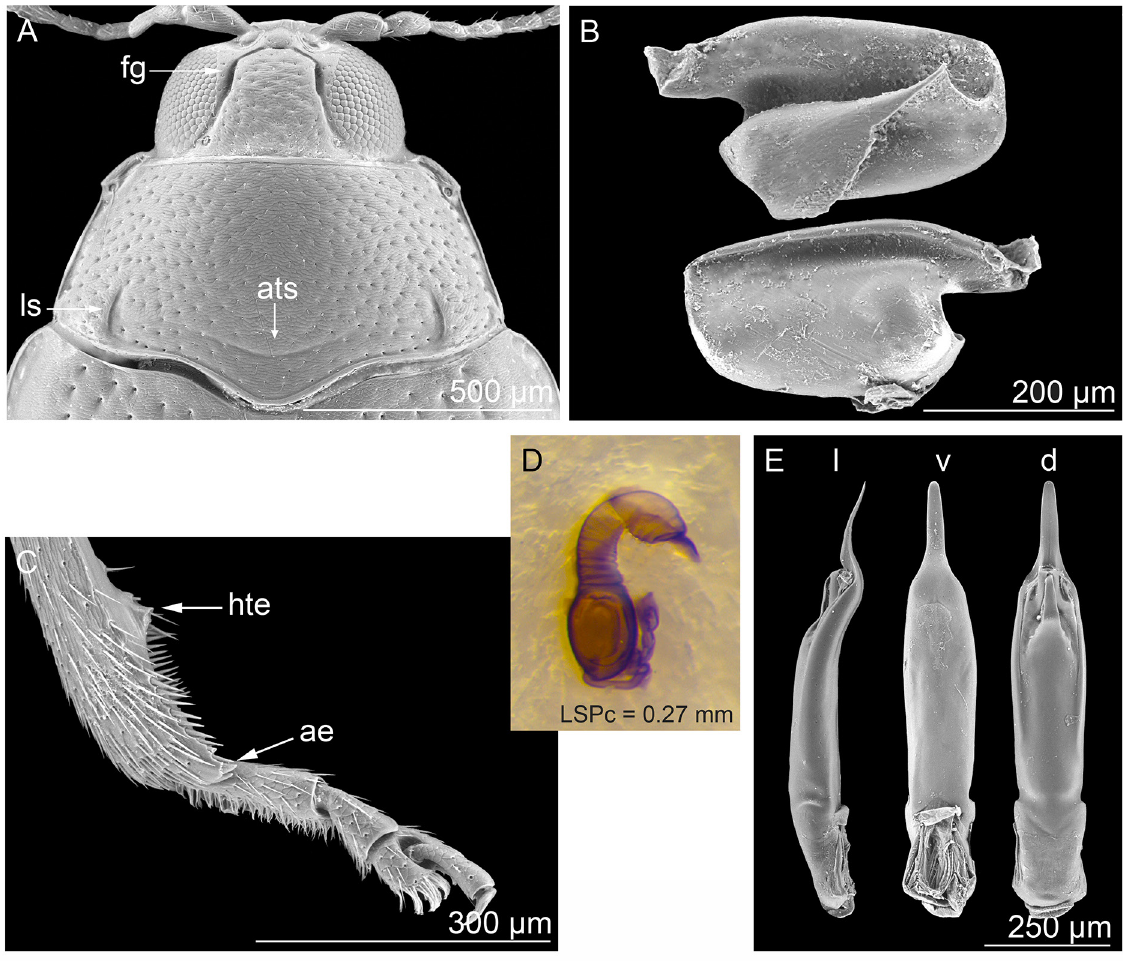
Fig. 13. Morphological traits of Crepicnema parvula (Jacoby, 1885) comb. nov., Solomon Islands, San Cristobal (BMNH). A . Head and pronotum. B . Metafemoral spring. C . Hind tibia and tarsus. D . Spermatheca. E . Median lobe of aedeagus in lateral (l), ventral (v) and dorsal (d) views. Abbreviations: ae = apical emargination with thickset spines; ats = antebasal transverse sulcus; hte = emargination on outer margin of hind tibia; ls = longitudinal striae; LSPc = length of spermathecal capsule; tfg = frontal